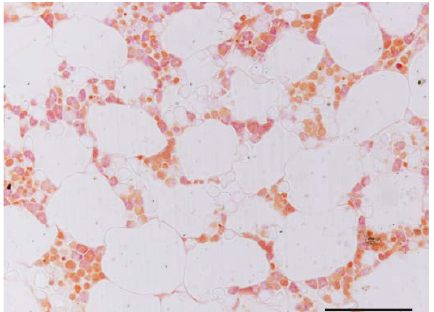
Figure 5: Photomicrograph of histological section from the TCP group. Evidence of empty spaces fi lled by adipose bone marrow due to the absence of osteointegration of TCP granules (scale bar: 150 μ